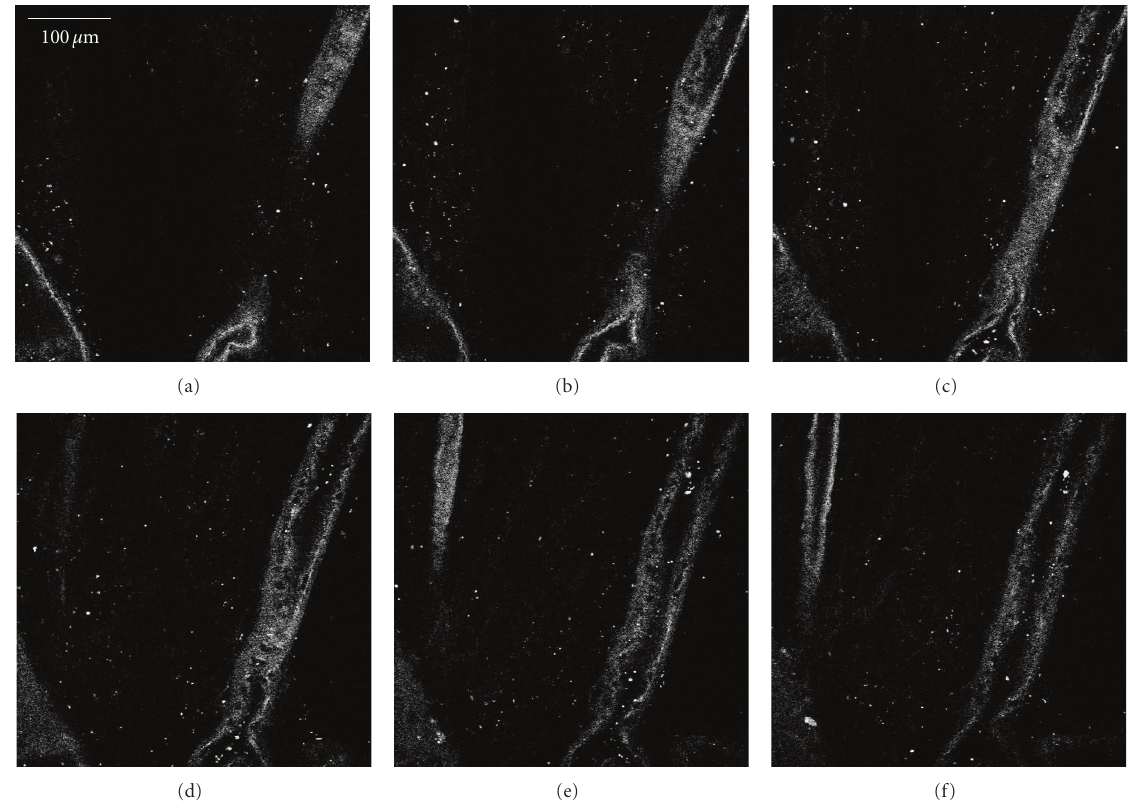
Figure 6: Vascular bed of a human retina imaged by second harmonic generation (SHG). Serial z -sections, spaced 12 μ m apart, of a human retina are shown beginning with (a) through (f). The images shown are collected using the 800nm near infrared laser excitation with a collection window of 390–410nm. The collagen structure of a large blood vessel is clearly visible through the series, which represents a height of 60 μ m.